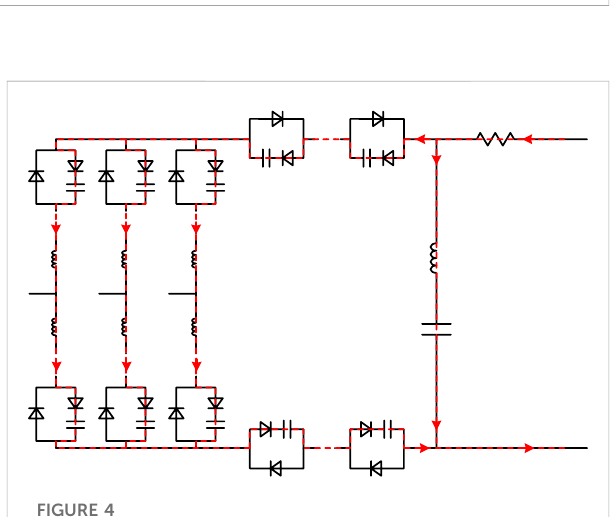
FIGURE 4 Schematic diagram in uncontrollable precharging